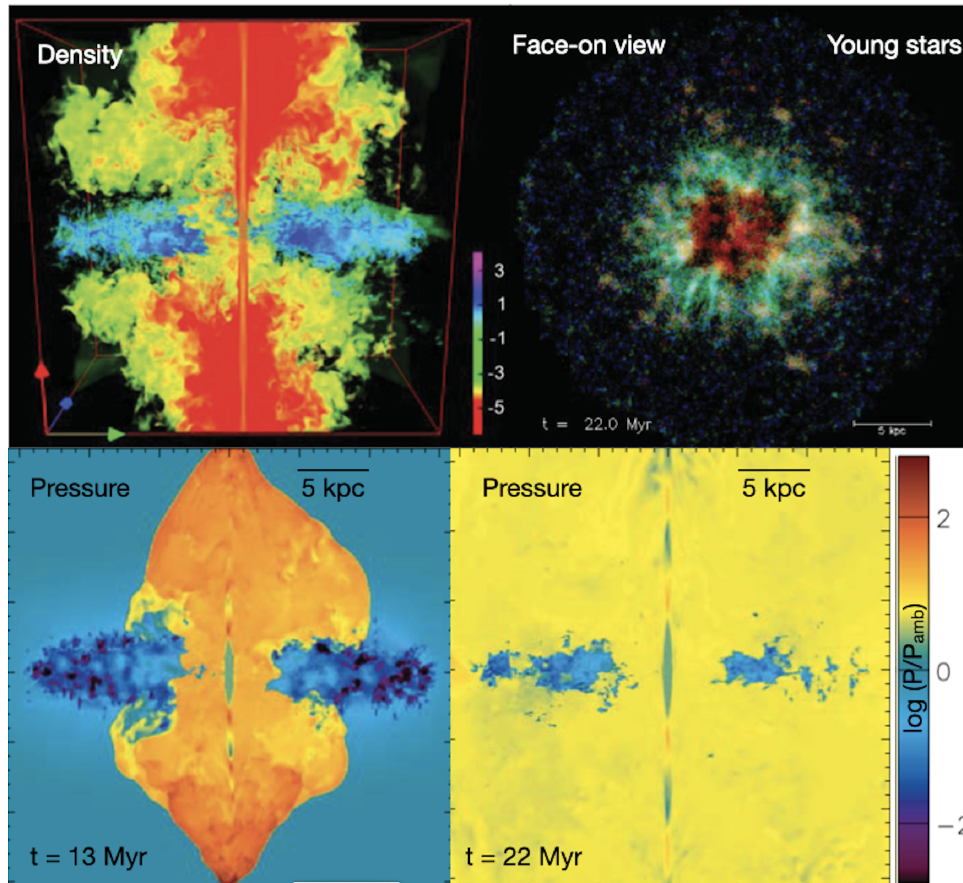
Figure 2. Hydrodynamic simulation of jet–induced star formation in a gas–rich galaxy, adopted from [121]. All panels show the evolution 12 Myr after the onset of the jet (22 Myr after start of the simulation), except the bottom left panel, which is 1 Myr after jet onset. ( Top left ): Logarithmic density volume rendering. Blue colours show the dense ISM in the modelled galaxy from the centre of which bipolar, very light jets emerge vertically upwards and downwards. Gas cooling is prevented below 10 4 K, which sets the approximate disk temperature. The radio lobes (red and yellow) surround and compress the disc. ( Top right ): Map of stars formed during the simulation. Red: stars that formed before the jet was active; green, stars formed since the jet was active, except the ones shown in blue, which are stars formed within the last Myr. The centre of the galaxy is cleared of gas, and a ring of enhanced star formation is driven outwards. Overall, the enhancement of the star formation rate peaked at a factor of a few during the simulation. About 10 percent of the gas mass was estimated to be converted to stars during one duty cycle. ( Bottom ): Pressure maps (midplane slices) 1 Myr ( left ) and 12 Myr ( right ) after jet onset. Shown is the logarithm of the ratio of the local pressure over the initial ambient pressure. In both bottom panels, the jet points upwards and